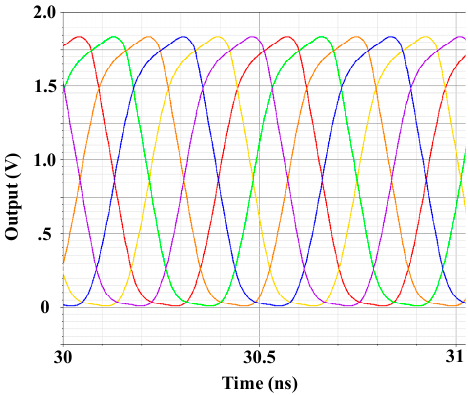
Figure 7. The transient simulation waveforms of the proposed six-phase output VCO.